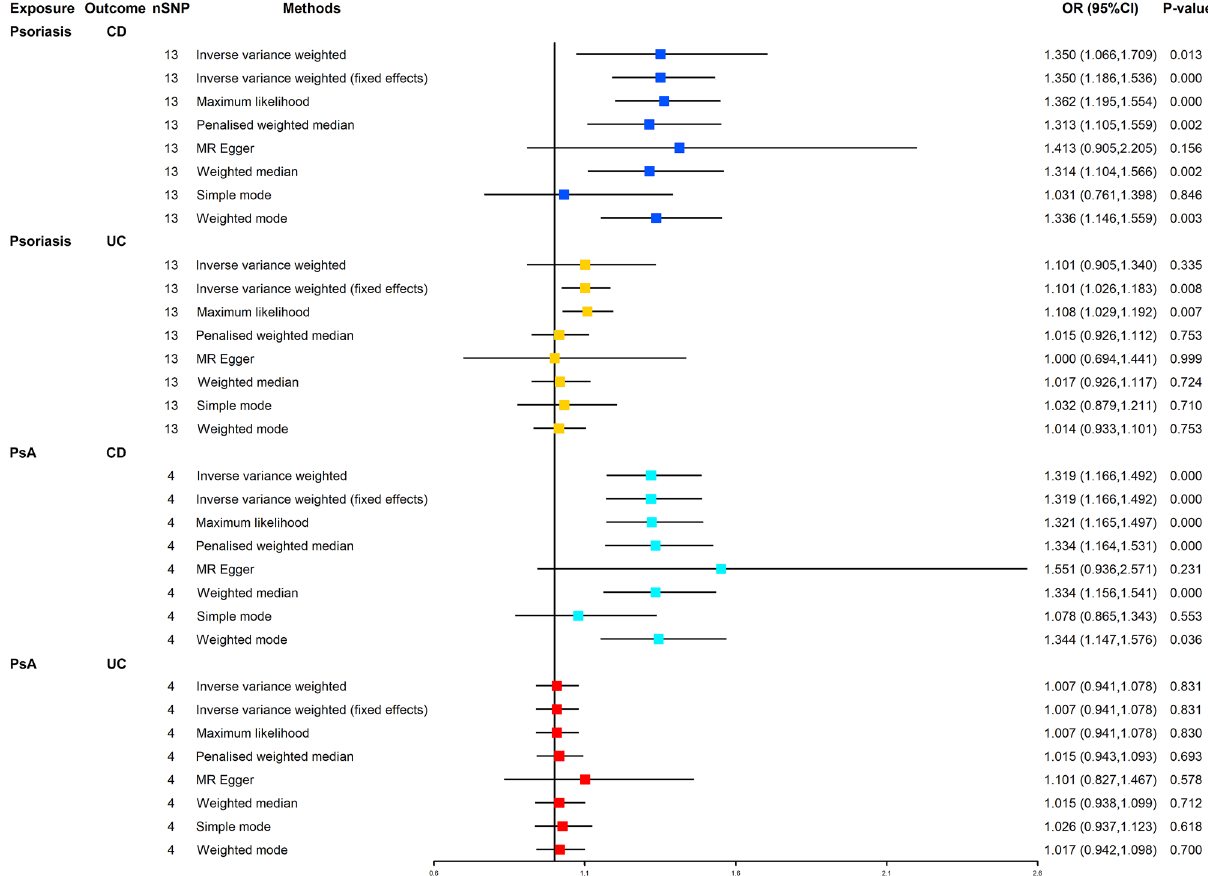
Figure 1. Forest plot for MR analyses of the causal effect of psoriasis and PsA on CD and UC. CD Crohn’s disease, UC ulcerative colitis, PsA psoriatic arthritis, nSNP number of single nucleotide polymorphism.